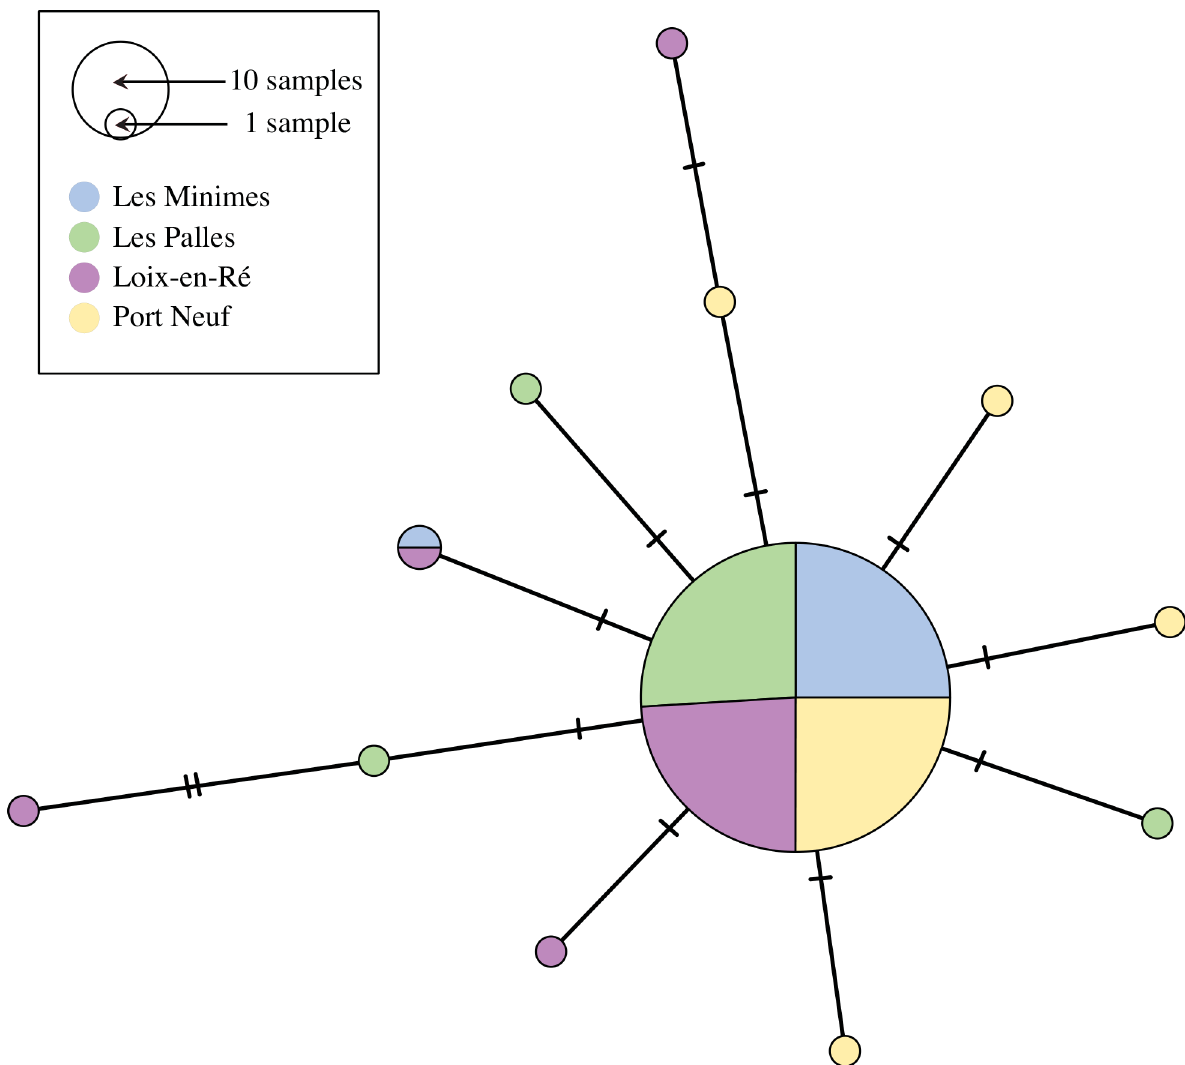
Fig 6. Median-joining network representing the 12 unique haplotypes found across 477 bp of the mitochondrial cox1 gene in 116 Mimachlamys varia individuals from four sampling sites. Each filled circle represents a unique haplotype and its size is proportional to the number of individuals sharing this haplotype. Each circle is colored proportionally to the number of individuals from each sampling site. The number of mutations separating connected haplotypes is represented by tick marks on the